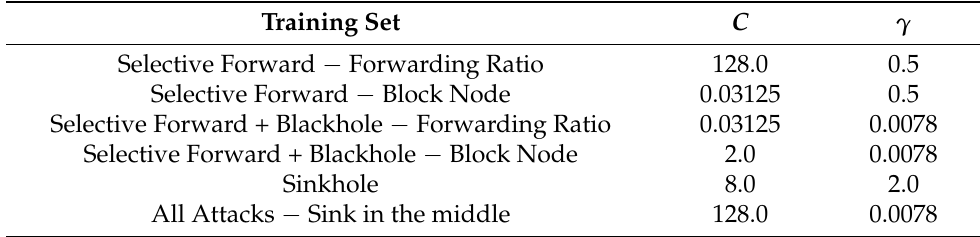
Table 5. SVM ( C , γ ) values from our training results.